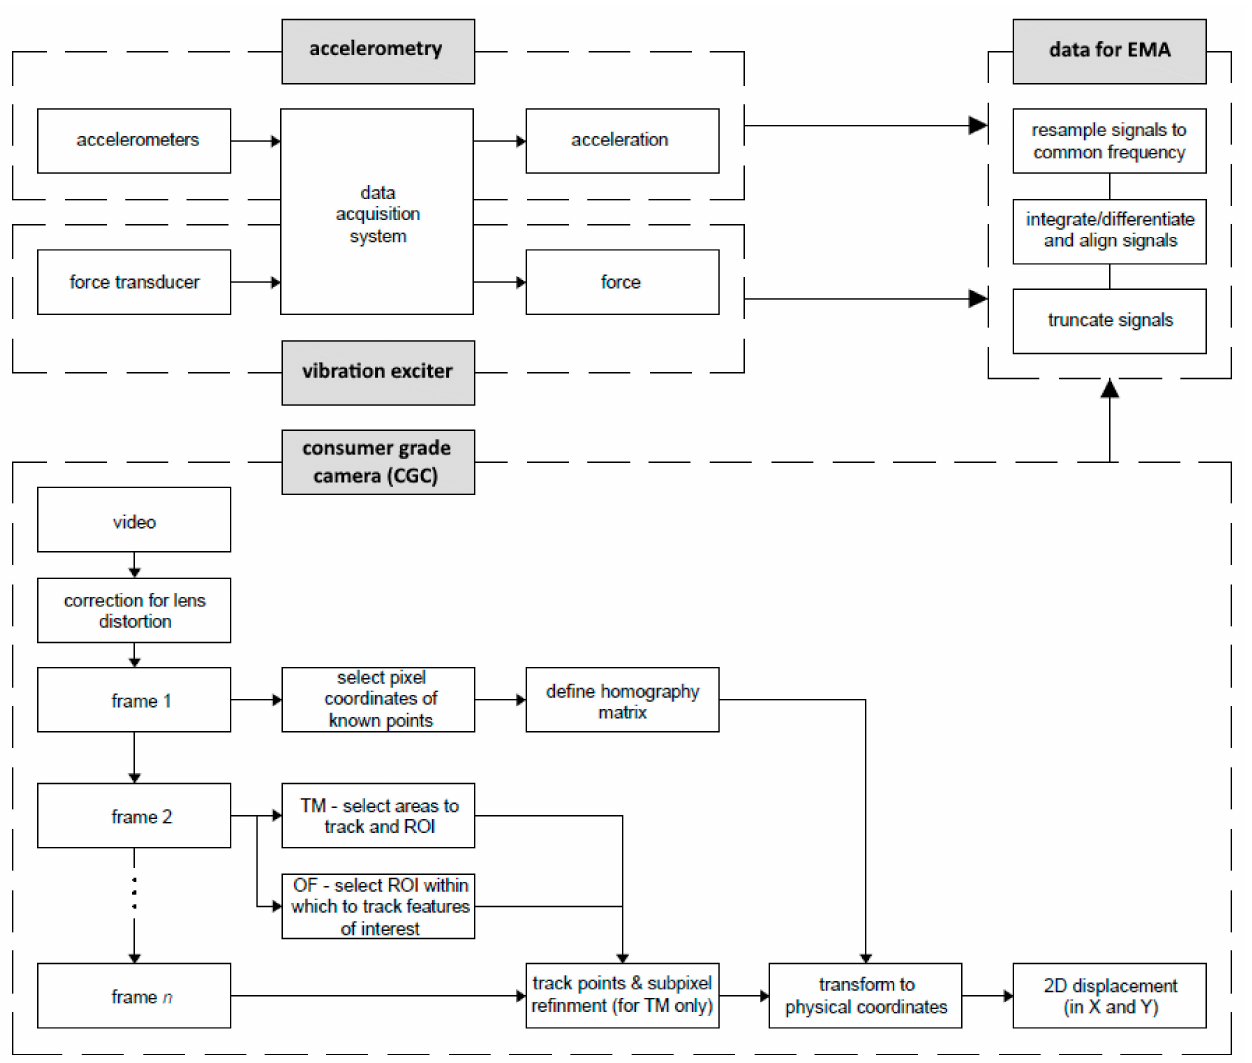
Figure 1. Outline of the data fusion undertaken to enable experimental modal analysis (EMA).